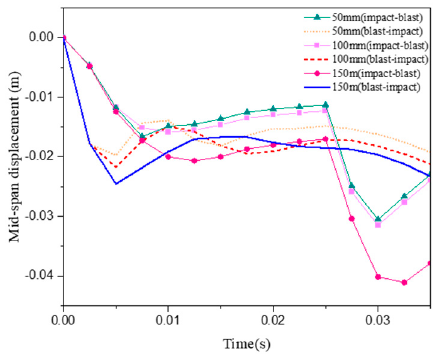
Figure 16. Time-history curves of mid-span displacement of beams under different transverse reinforcement spacing.